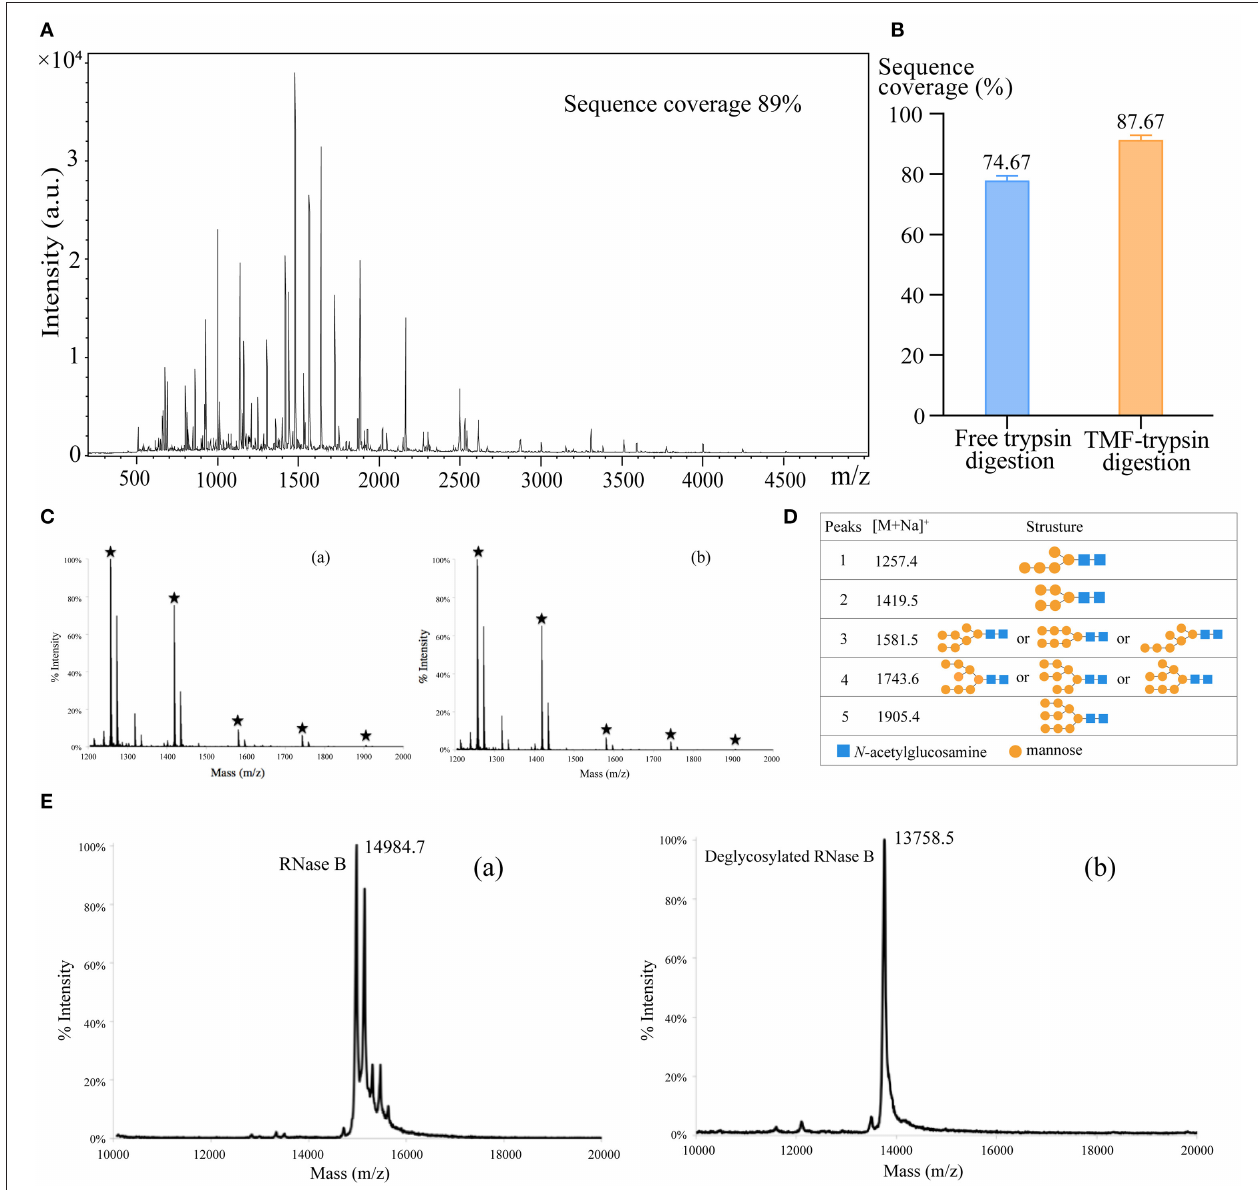
FIGURE 3 | (A) The MALDI-TOF-MS spectrum of BSA digests obtained by TMF–trypsin digestion for 3min. (B) Sequence coverages of BSA digested by TMF–trypsin and free trypsin at BSA 10 µ g/ml. (C) MALDI-TOF-MS spectra of N -glycans of RNase B deglycosylated with (a) TMF–PNGase F (room temperature, 3min) and (b) free PNGase F (16h, 37 ◦ C). (D) Observed peaks and proposed structures of N- glycans released from RNase B using TMF–PNGase F. (E) Spectra of RNase B (a) before and (b) after TMF–PNGase F digestion.